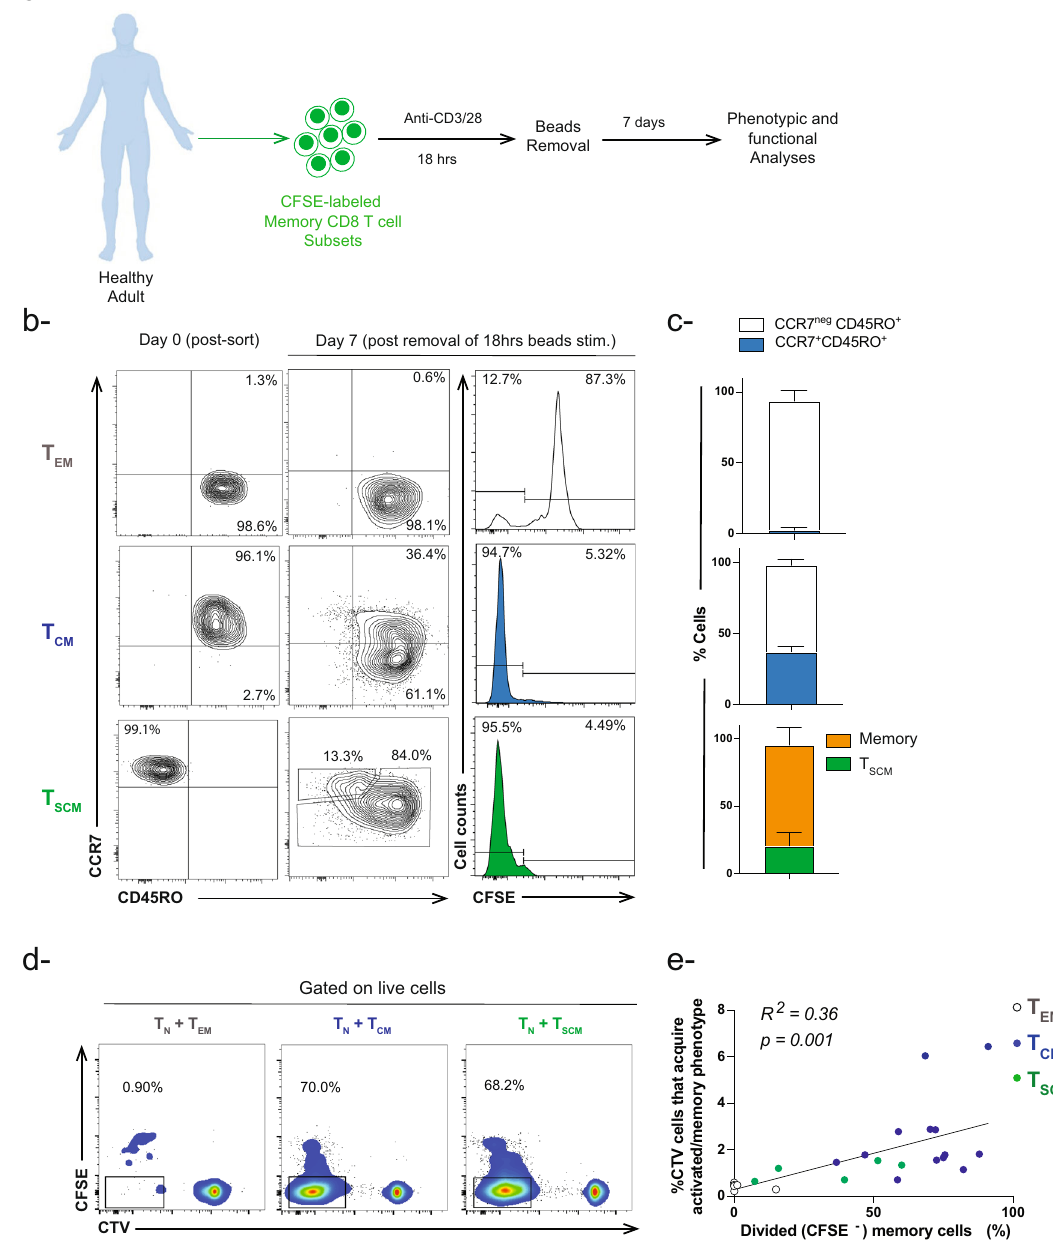
Fig. 2 Phenotype and proliferation capacity of activated memory CD8 T cell subsets. a Experimental setup diagram for activation of memory CD8 T cell subsets. b Representative fl ow cytometry contour plots showing the phenotype of memory CD8 T subsets at Day 0 and Day 7 after removal of anti-CD3/ CD28 stimulation. Histograms showing proliferation of CFSE-labeled memory CD8 T cell subsets. c Bar-graph showing the percentage of memory CD8 T cells that maintain or change their phenotype following removal of TCR stimulation ( n = 3 – 6). d Representative fl ow cytometry plots showing proliferation of CFSE-labeled activated memory CD8 T cell subsets in the presence of CTV-labeled naïve CD8 T cells. The percent in the graph represents the proportion of dividing memory CD8 T cells (CFSE neg ). e Pearson coef fi cient correlation analyses between percent of dividing memory CD8 T cell subsets in the presence of naive CD8 T cells versus percent of naïve CD8 T cells that acquired an activated/memory phenotype. Simple linear regression test was applied between the two variables ( n = 24, R 2 = 0.36 p = presence of anti-MHC-I antibody (5 μ g/ml). Under these naïve CD8 T cells that acquired an activated/memory phenotype conditions, we observed similar results where upon blocking (CD45RO + ) upon blocking MHC-I at different concentrations compared to isotype controls (Figs. 5b, c, S3e). It is noteworthy to MHC-I molecules, there was a signi fi cant decrease in the mention that we observe a change in the frequency of CTV-naïve frequency of naïve CD8 T cells that acquire activated/memory and CFSE-memory CD8 T cells upon blocking MHC-I compared phenotype (mean ~0.9% vs 3%, respectively) (Fig. 5d, e). In to controls. To further validate our results, we repeated the co- summary, these data indicate that naïve CD8 T cells contact culture conditions 3:1 (memory:naïve) ratio in the absence or activated memory T cells and acquire an activated/memory